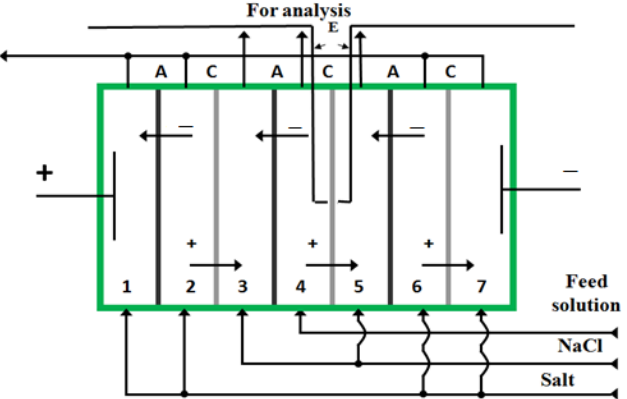
Figure 1. Seven-compartment electrodialysis cell with alternating cation (C)- and anion (A)-exchange membranes, “+”—cation, “ − ”—anion, E—electrodes (Ag/AgCl). The pH value of the mixed solutions being fed into the 4th compartment was in the range 5.7–6.5, which is close to the isoelectric point of tryptophan or proline. The pH value of solutions was measured using a laboratory ionometer I-160MI (RPA Measuring equipment, Moscow, Russia).